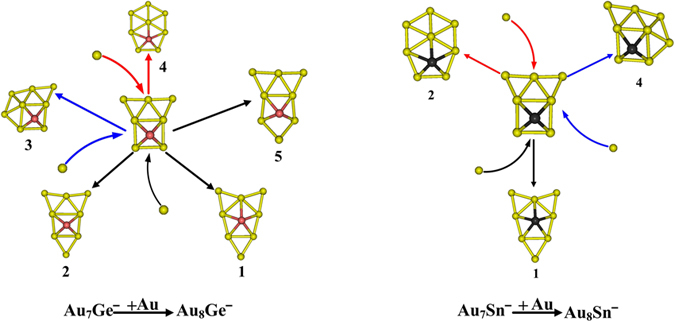
The structure evolution of the clusters from Au7M− to Au8M− (M = Ge, Sn).The structure of the Au7M− (M = Ge, Sn) cluster was obtained from the literature31. The dopant atoms are shown in color (Ge in red, and Sn in black). The numbers are the same as in Table 1.